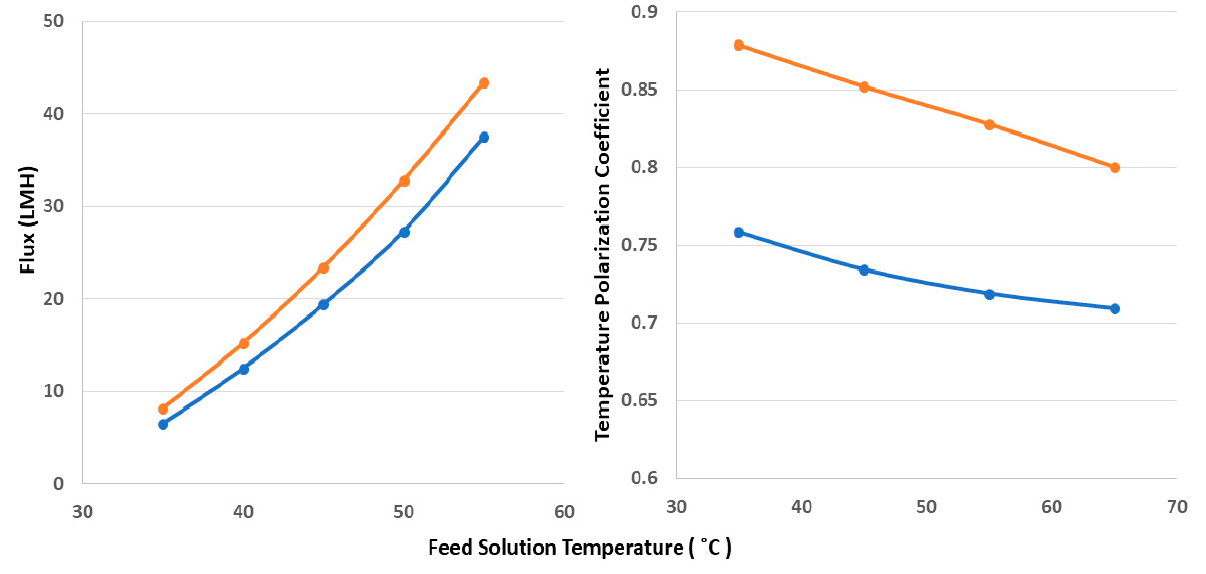
Figure 6. Water permeate flux and TPC values during a 24-h DCMD test using PVDF-Co-HFP (blue color) and CNT-coated PVDF-Co-HFP (orange color) membranes at a constant coolant temperature of 15 °C.